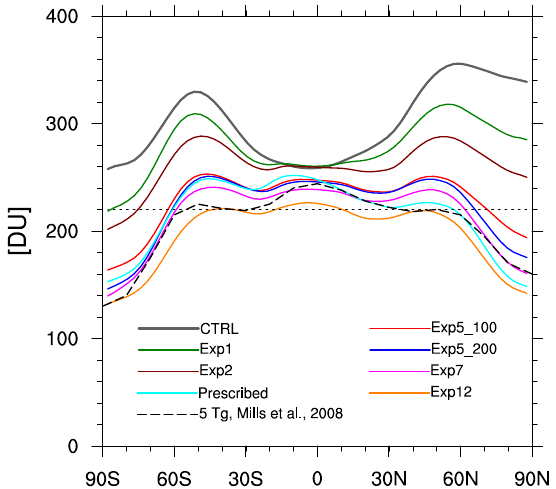
Fig. 15. The zonally averaged ratio between the erythemally weighted UV irradiance at local noon for Exp5_100 and the CTRL run, for the first 5yr of the model run. No data is available during the polar night when the sun is below the